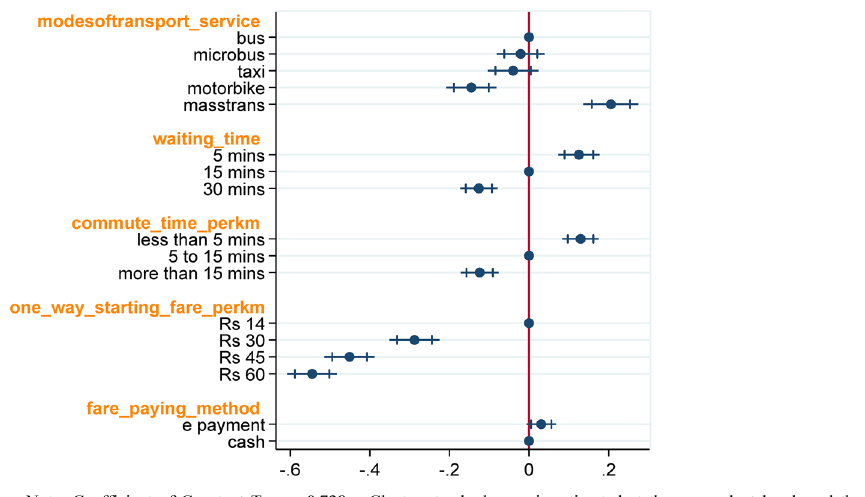
Fig. 3 Average causal effect on the external choice probability. Coefficient of Constant Term Cluster standard error is estimated at the respondent level, and the horizontal bar is adjusted within a 95% confidence interval. Rs represents Nepalese rupees